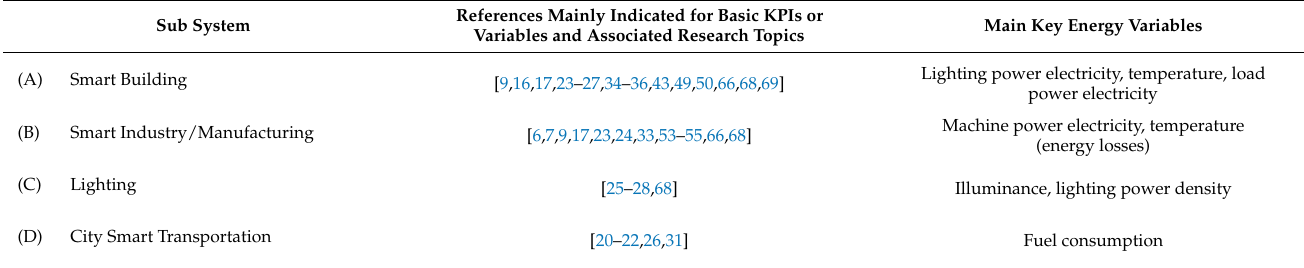
Table 5. References including basic KPIs and energy variables associated with the subsystems of Figure